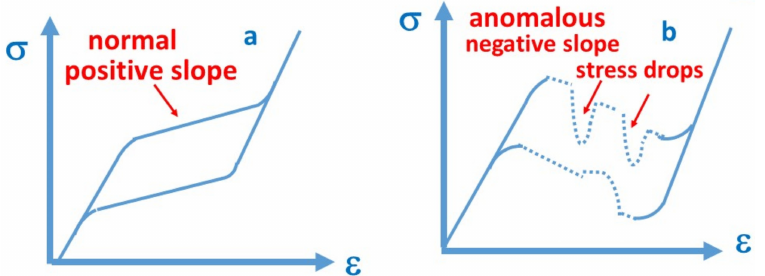
Figure 1. Stress–strain curves schematically: ( a ) typical loop with positive slope of the uploading branch, ( b ) anomalous loop with negative overall slope and stress drops on